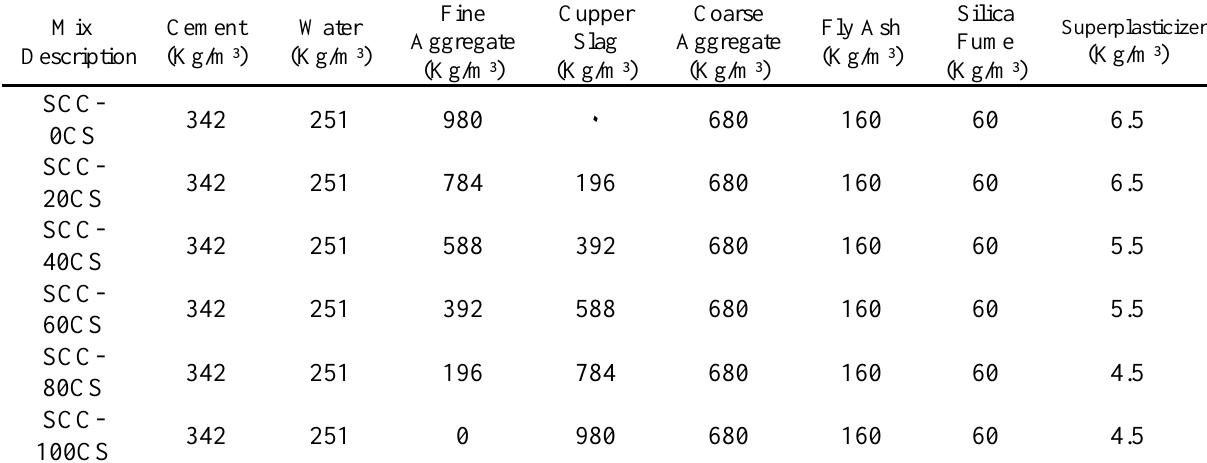
Table 3. Mix proportion of self-compacting concrete